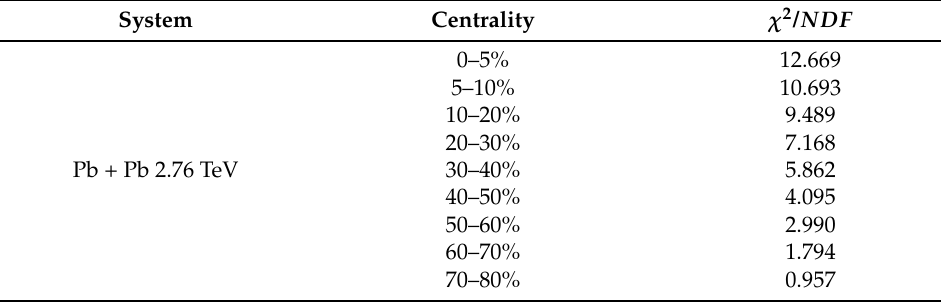
Table A2. The χ 2 / NDF of the fitting results in Figure